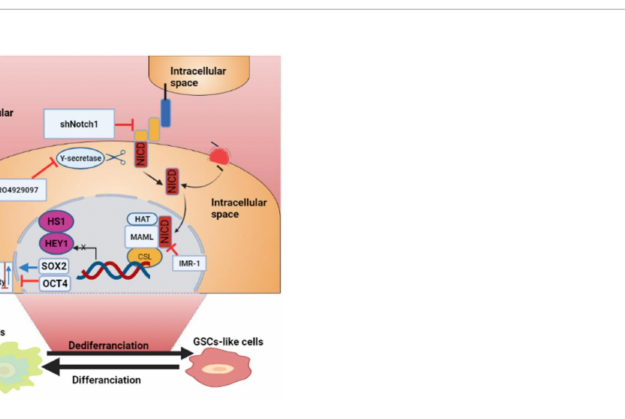
FIGURE 3 | Theroles of glioma stem cell(GSC) exosomes inglioma. GSC exosomes improve thestemness andtumorigenicity ofnon-GSC glioma cells by conveying Notch1protein via the Notch1signalingpathway (BioRender.com was used to create this fi